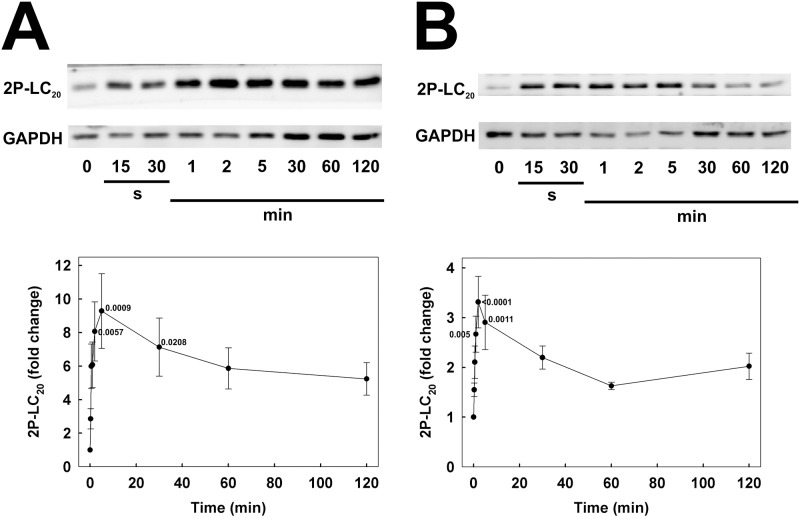
Confirmation of serum-induced LC20 diphosphorylation at T18 and S19.Human coronary (A) and umbilical arterial smooth muscle cells (B) were treated with serum at time zero, as described in the legend to Fig 1, and diphosphorylation of LC20 at T18 and S19 was assessed by regular SDS-PAGE and western blotting with an antibody that specifically recognizes LC20 only when phosphorylated at both T18 and S19. Representative western blots are shown in each panel above cumulative quantitative data depicting the time-dependent changes in LC20 diphosphorylation expressed as fold change relative to the value at time zero (prior to addition of serum) after normalization of loading levels using GAPDH. Values indicate the mean ± SEM (n = 6). Significant differences from the value at time zero are indicated with their respective p values (Dunnett’s post hoc test).